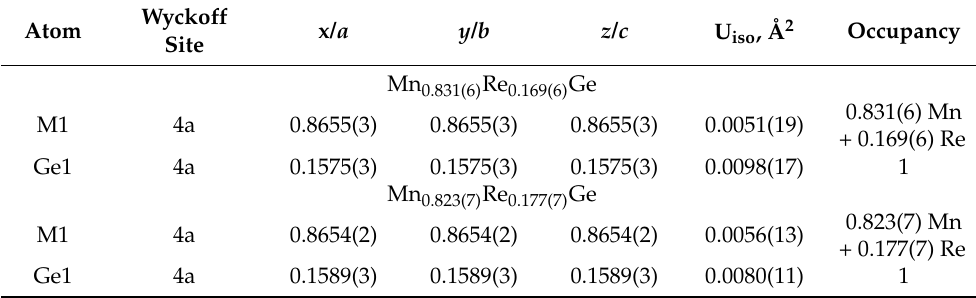
Atomic coordinates and thermal displacement parameters for the Mn 1 − x Re x Ge powder